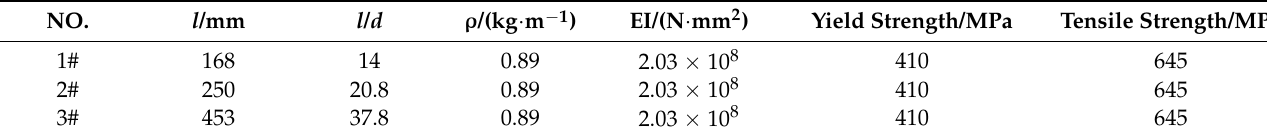
Table 1. Geometric parameters of the specimens.